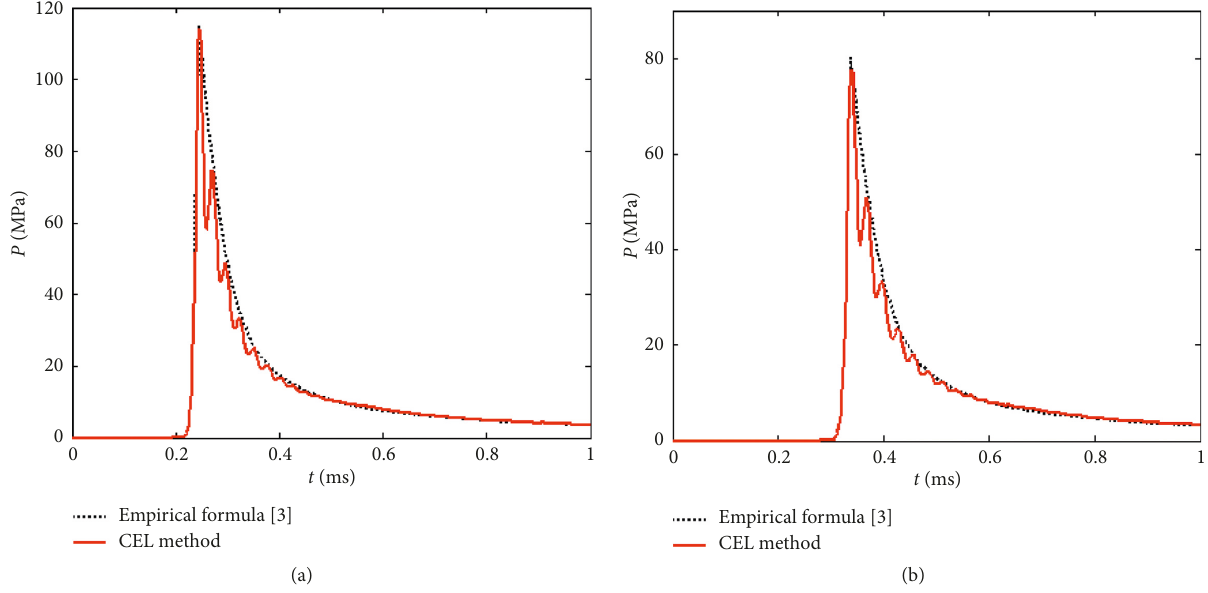
Figure 5: Comparison of shock wave pressure time histories from numerical results and Zamyshlyayev empirical formula [3]. (a) r � 10. (b) r � 13.